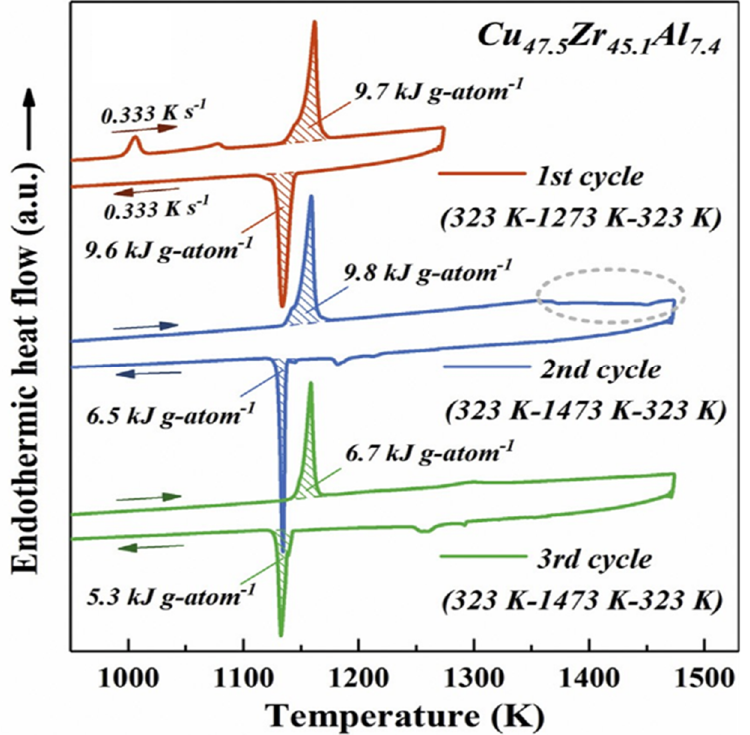
Figure 4. Multiple DTA measurements (0.333 K/s) of Cu47.5 alloy. The first up- and down-scan cycle is well below 1350 K and the last two cycles reach 1473 K. A remarkable exothermic reaction observed at the temperature above 1350 K in the second up-scan curve is marked by a gray dashed circle. Reprinted with permission from ref. [43], Figure 9b, Copyright 2020 Elsevier.